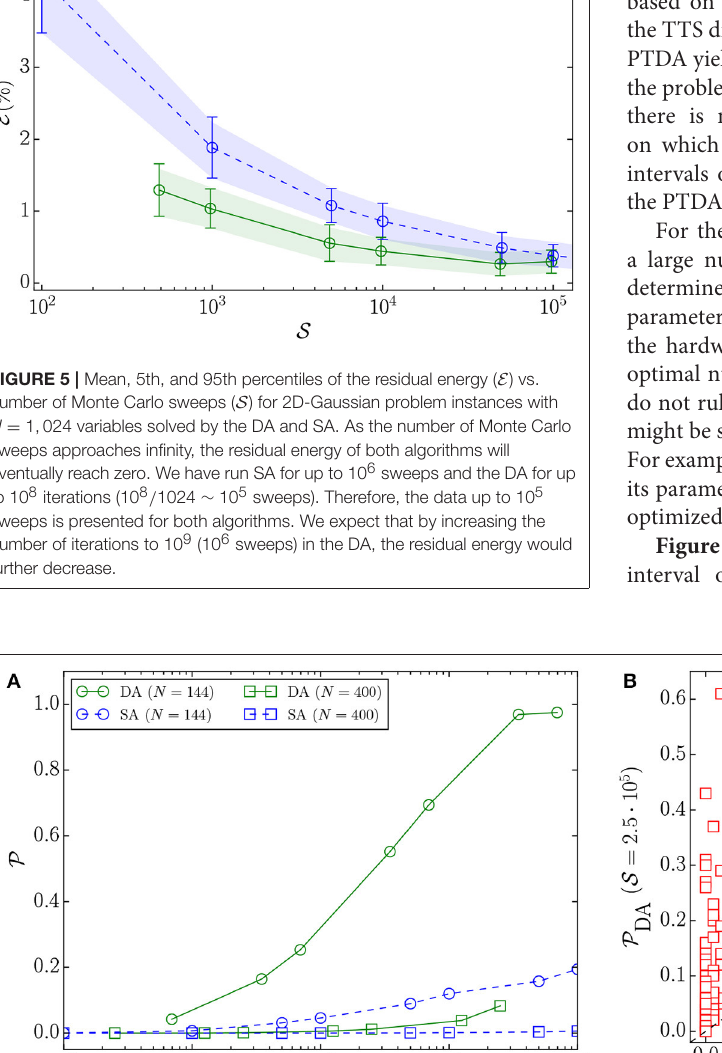
Frontiers in Physics |